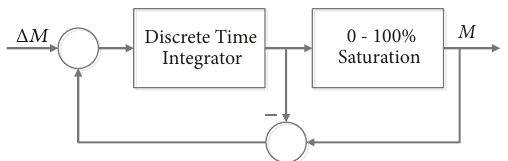
Figure 5: Constraint handling scheme using the antiwindup back-calculation method.